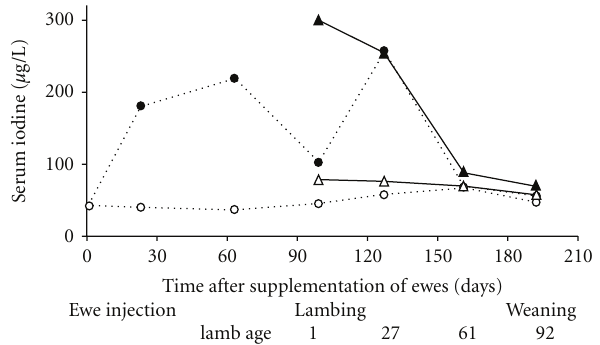
Figure 6: E ff ect of no treatment ( (cid:2) ) or intramuscular injection of 400mg iodised oil (about 7mg I/kg LW) ( • ) administered to ewes during early gestation on the concentrations of serum total I in ewes ( (cid:2) , • ) and their lambs ( (cid:4) , (cid:2) ). The percentage perinatal mortality and the thyroid-weight :birthweight ratio (g/kg) in lambs from the unsupplemented and I-supplemented ewes were 27% versus 16% and 0.70 versus 0.27, respectively. Ratios > 0.4g/kg indicate that a flock is at risk of deficiency and is likely to respond to I supplementation [10, 13].